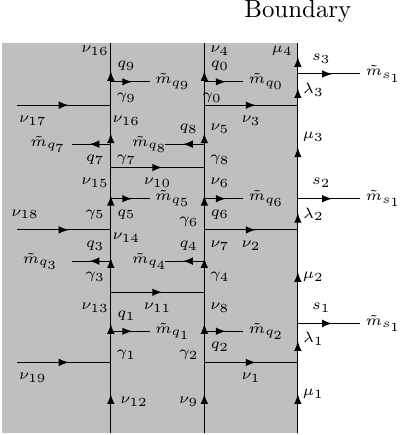
Figure 5 . A portion of the lattice ~(cid:0) on which the basis states of the Fourier-transformed Hilbert space. See also (cid:12)gure 2(d) for